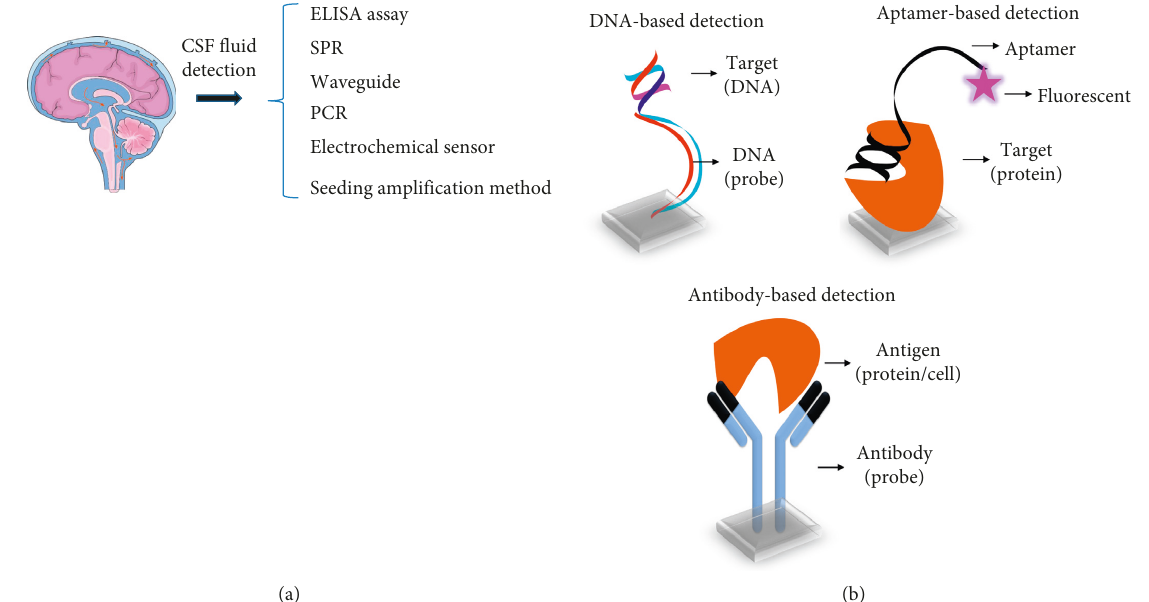
Figure 7: Hydrocephaly detection using CSF fluid biomarkers and identification by a biosensor. (a) Biomarker identification by a different type of biosensor; (b) CSF biomarker detection by different probes such as DNA, antibody, and